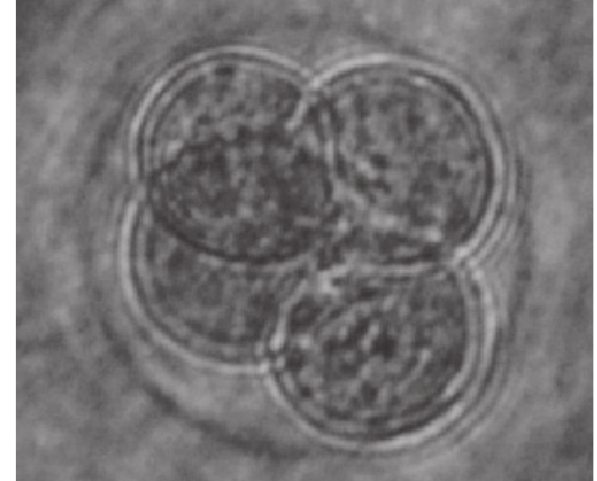
(controle) sem alterações Figura 1. Embrião do grupo G Figura 4. Embrião exposto aos vírus e ao extrato etanólico da 1 morfológicas após 24 h de incubação. É possível verificar a casca de Punica granatum (Grupo G zona pelúcida íntegra e o corpúsculo polar (100x, 5,7x zoom).